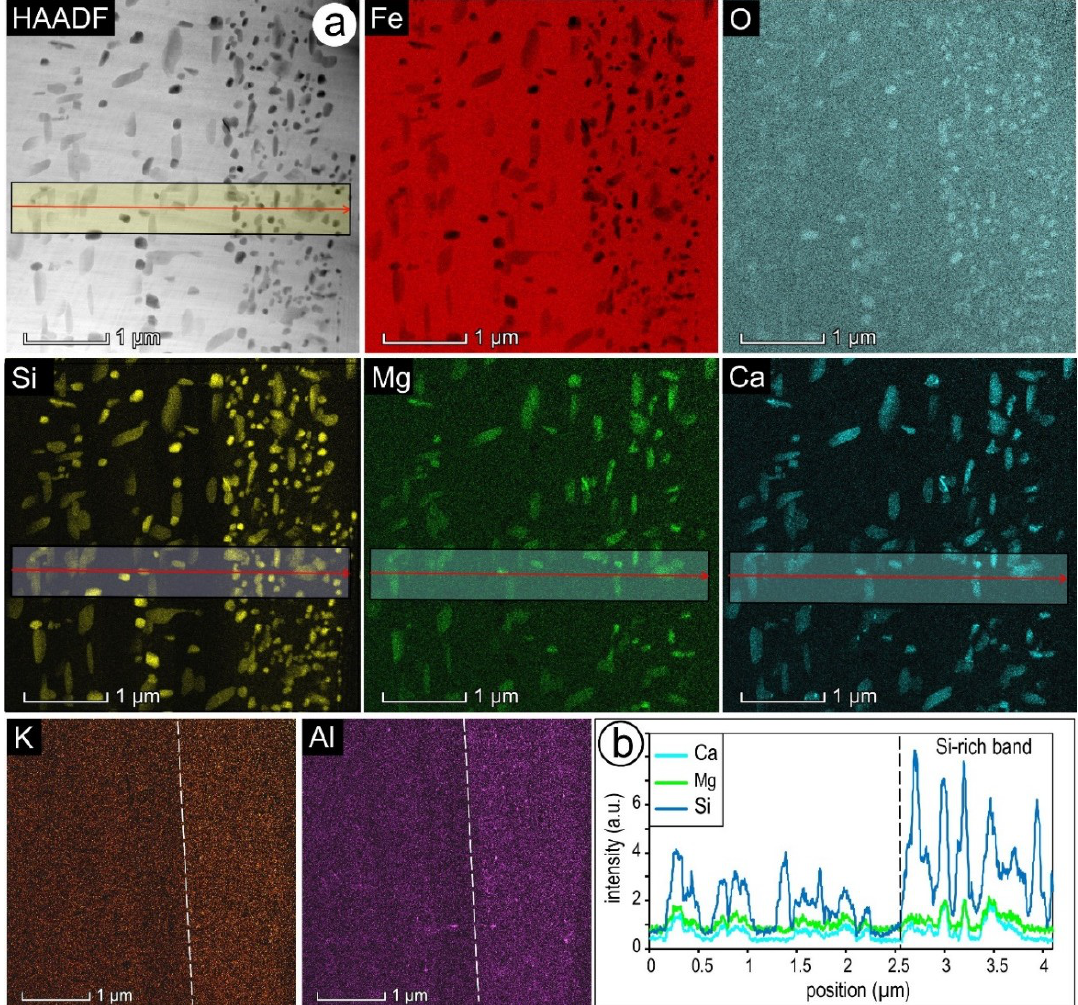
Figure 8. ( a ) HAADF STEM (left side) image and STEM-EDS maps showing the presence of inclusions within magnetite (location #4, E transect; foil #5). Note variation in size and shape of inclusions with element concentration, whereby the smallest, bleb-like are highest in Si and Mg-, Ca-bearing ones are fine- to coarser acicular inclusions (calc-silicates). In contrast Al and K show banding, with slightly higher concentration overlapping with the band with densest inclusions. ( b ) Profile across particles in ( a ) showing sharp variation in Si signal across the contact between the bands with variable size / density inclusions. There is however, no to little variation in the Ca and Mg signals corelating with the fact that many of the Si-high blebs are SiO 2 (quartz?).